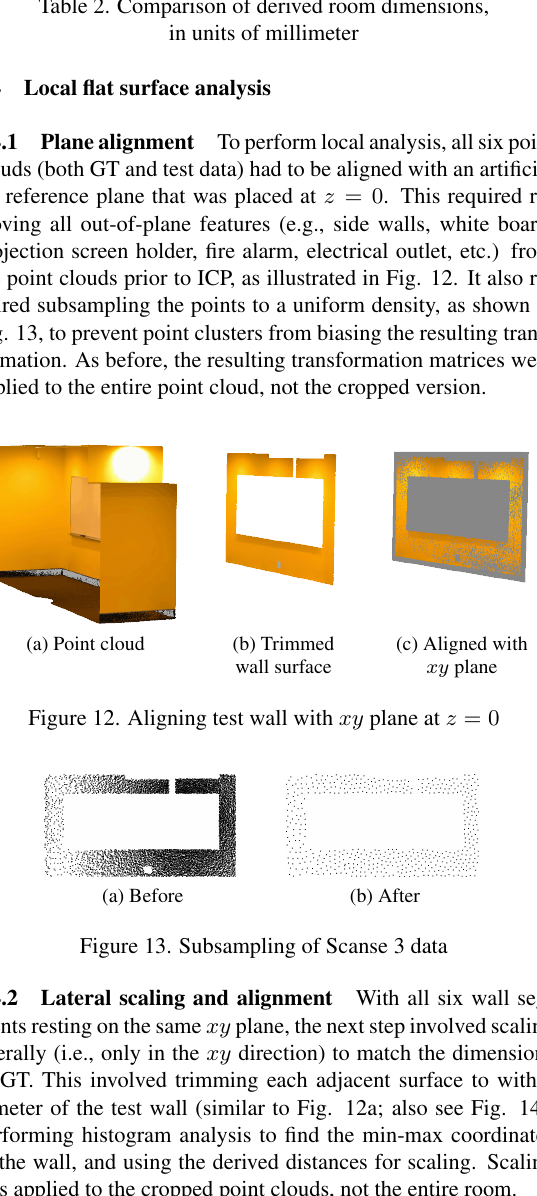
Table 2. Comparison of derived room dimensions,